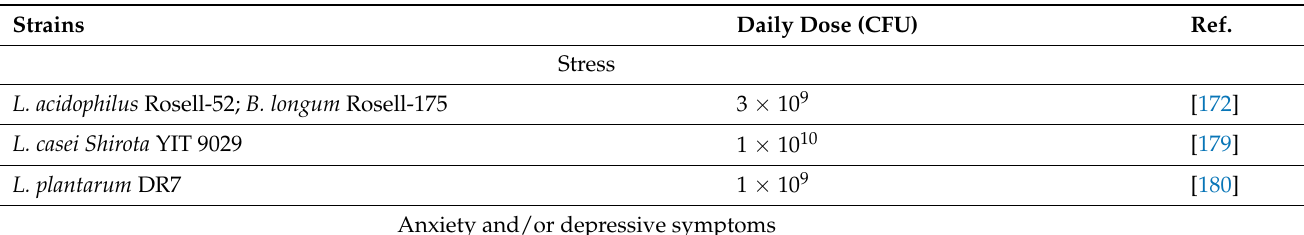
Table 2. Psychobiotics strains potentially useful in post COVID-19 mental problems. Strains Daily Dose (CFU) Ref.